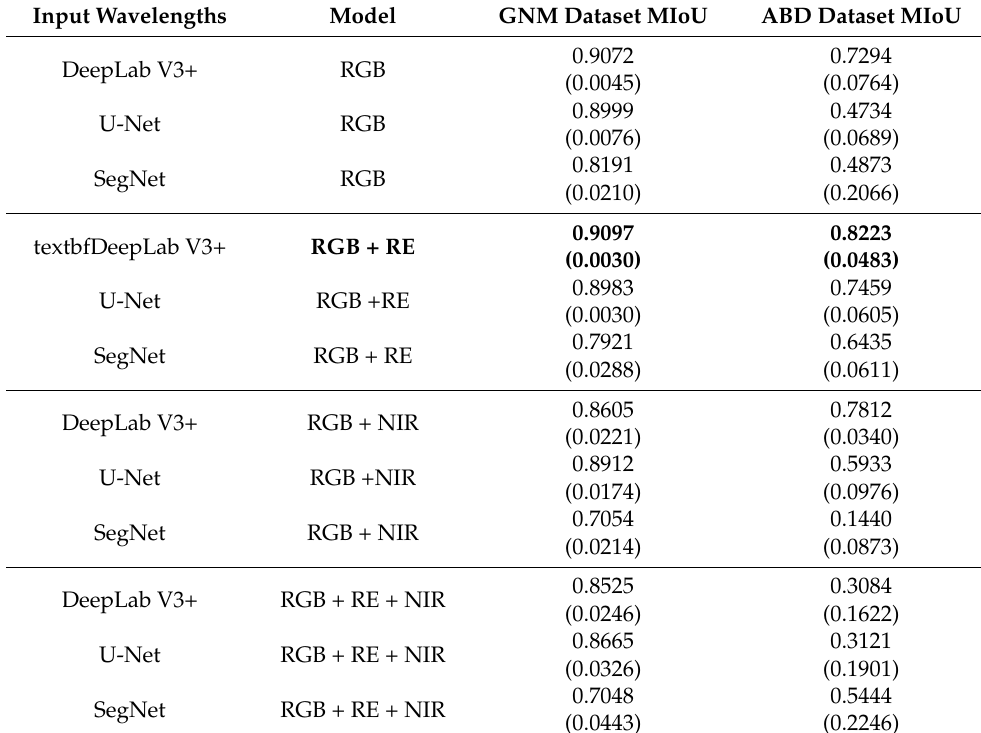
Table 2. Comparisons of model’s performance on the GNM (third column) and ABD (fourth column) dataset. The best performance of MIoU is boldfaced . Standard deviations are given in parentheses. Input Wavelengths Model GNM Dataset MIoU ABD Dataset MIoU DeepLab V3+ RGB